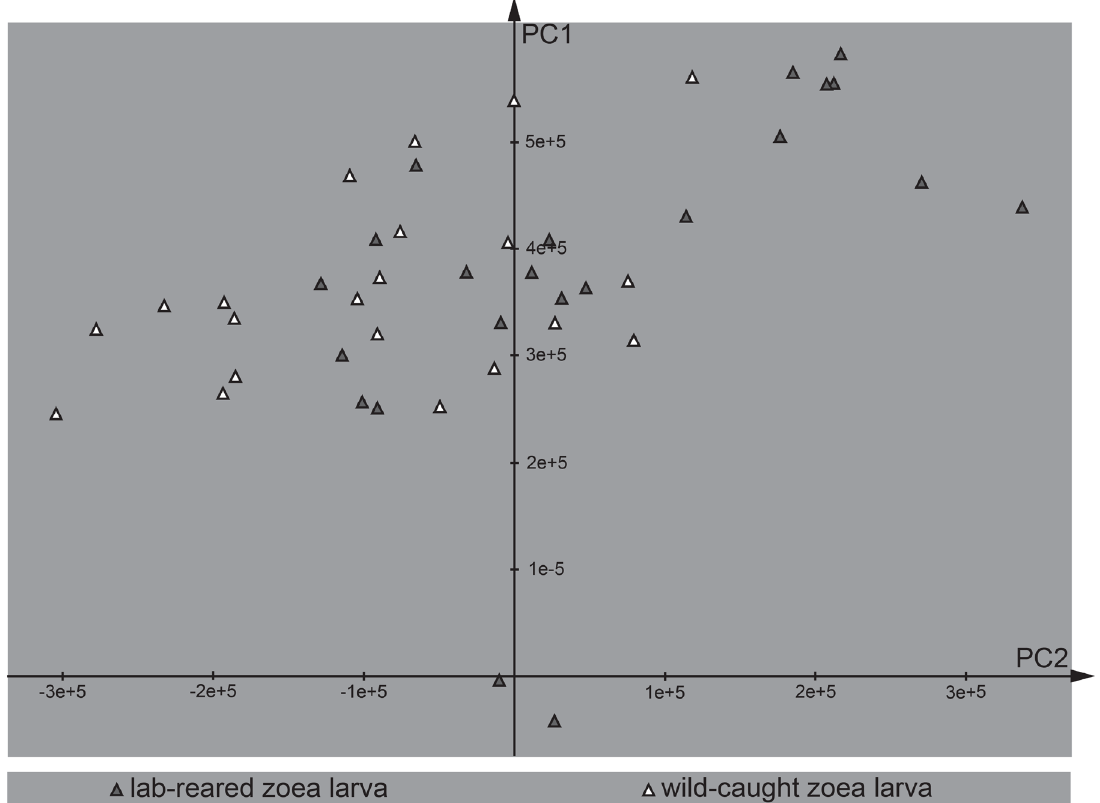
Figure 8. Plot of the first two principal components resulting from the principal component analysis (PCA) performed on the data generated by an elliptic Fourier transformation of shield shape in the group Hippoidea. Only zoeae larvae are considered. Principal component one (PC1) explains 86.1 % of apparent diversity in the data set, principal component 2 (PC2) explains 6.6 % of the apparent diversity in the data set. Factor loadings given in the Appendix (App. 2). Grouping of specimens according to origin of the material: from the wild or from a lab